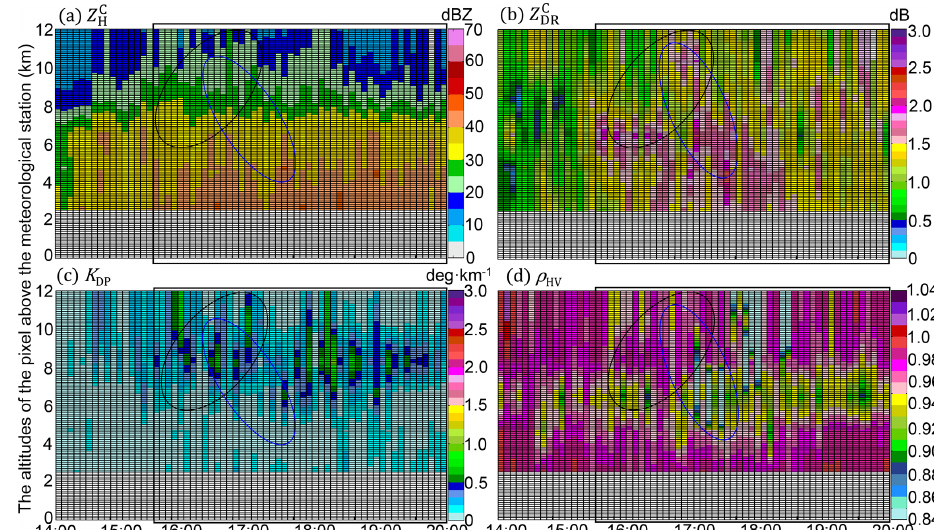
Figure 16. The same as Fig. 12 but for the LH station.